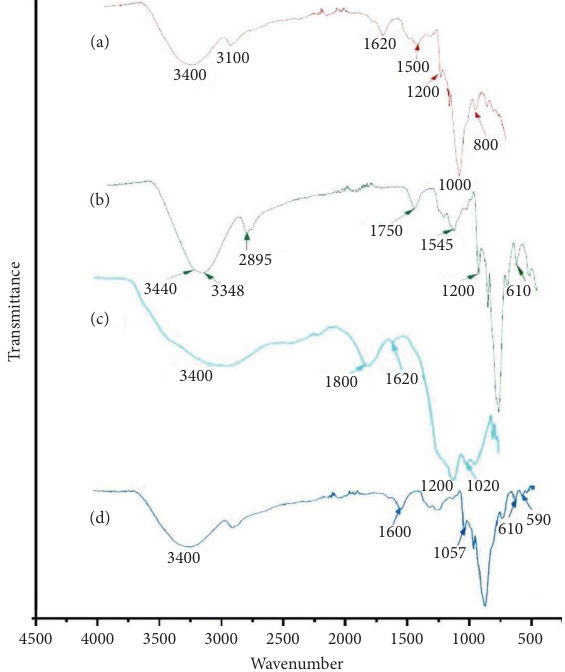
Figure 3: FTIR spectra: (a) cellulose nanofber, (b) MoS particles, (c) GO, and (d) cellulose/MoS 2 /GO